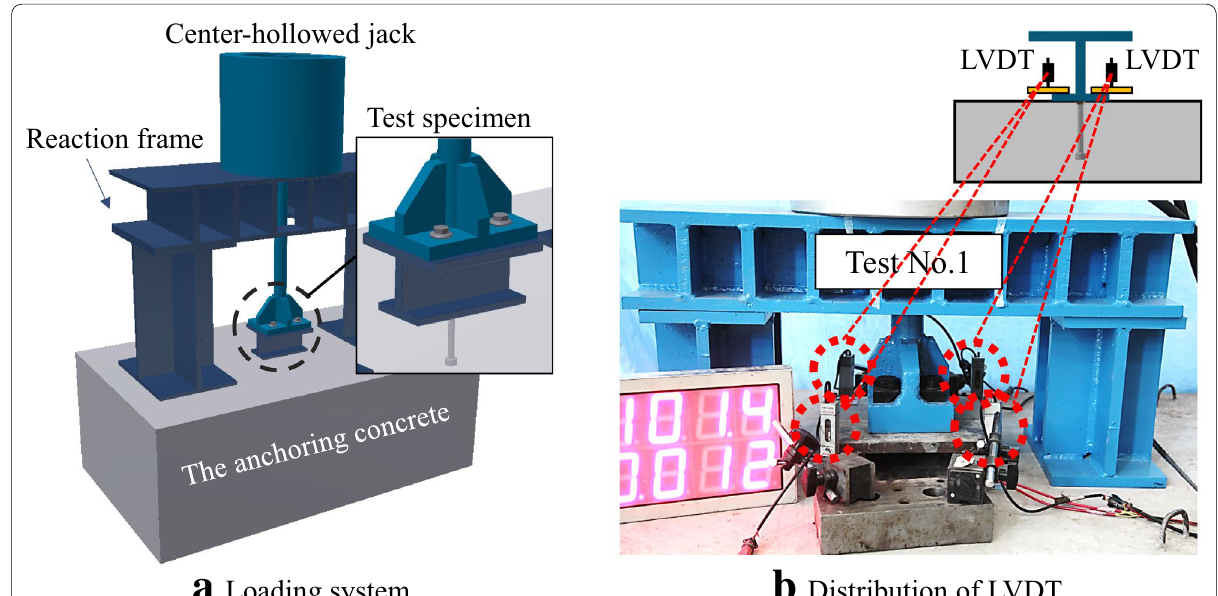
Fig. 4 Test setup and